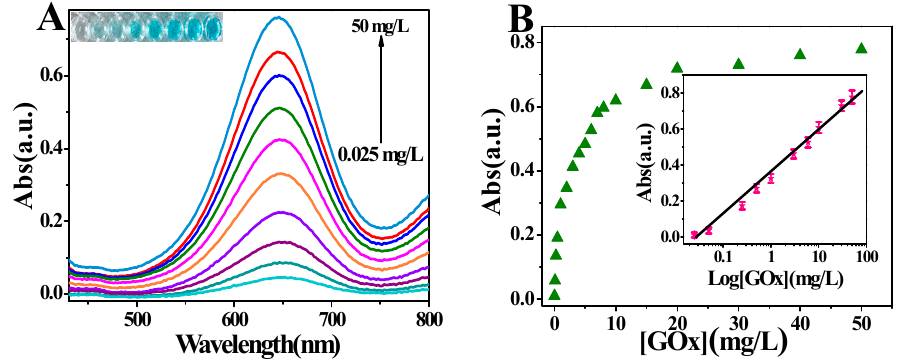
Figure 4. Analytical performances of the protocol for probing the activity of GOx. ( A ) UV/vis spectra of oxTMB catalyzed by the PO 43 − -capped CdS QDs formed in situ under visible-light irradiation in the presence of different concentrations of GOx. From bottom to top, the concentrations of GOx are 0.025, 0.1, 0.5, 1.0, 2.0, 4.0, 6.0, 10.0, 20.0, 50.0 mg/L. The inset shows the corresponding color change of oxTMB; ( B ) Absorption change and the linear relationship (insert curve) between the absorbance of oxTMB at 652 nm and the concentration of GOx. The error bars indicate relative standard deviation of four repeated experiments.